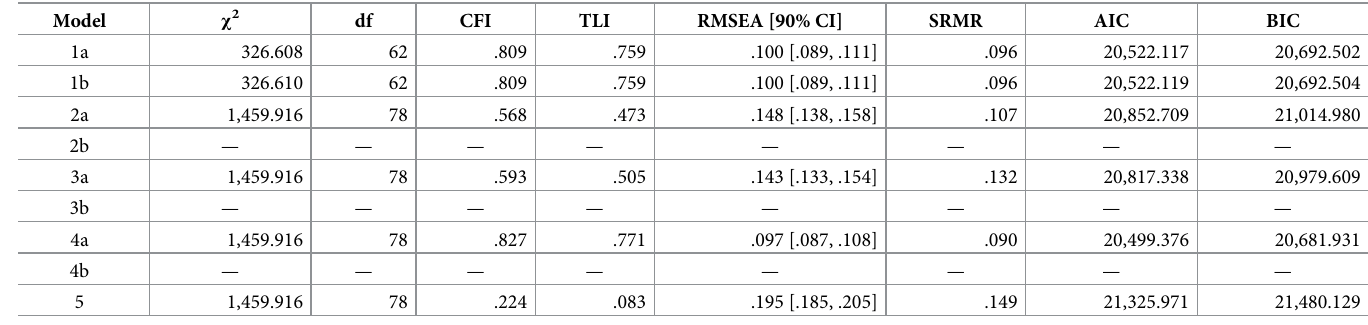
Table 4. Fit statistics for CFA